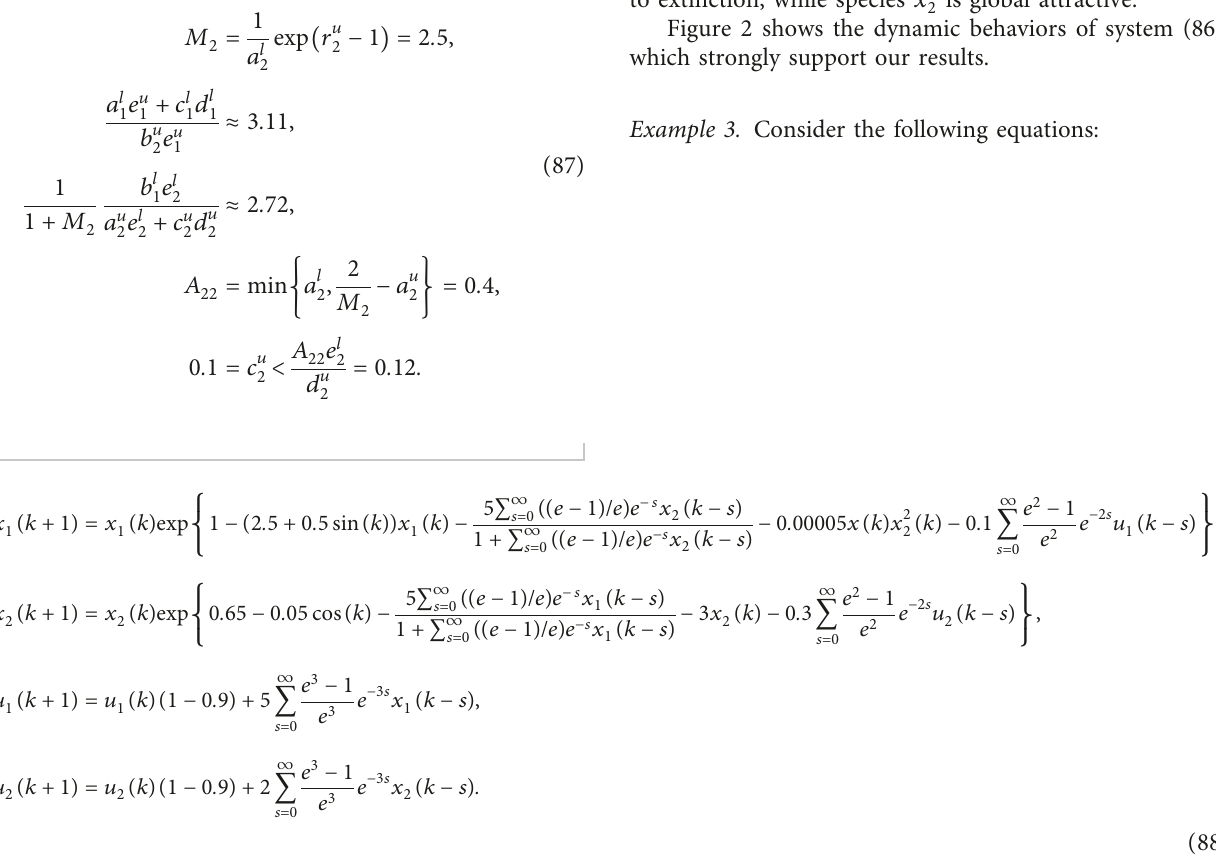
x k ,x k ,u k ,u k of system (83), with the initial conditions 1 ( 2 ( 1 ( 2 ( ( ) ) ) )) ... , n, n , 0 . 5 , 0 . 67 , 0 . 6 , 0 . 84 , s 1 , .. . , ) ( ) (cid:31) − − +